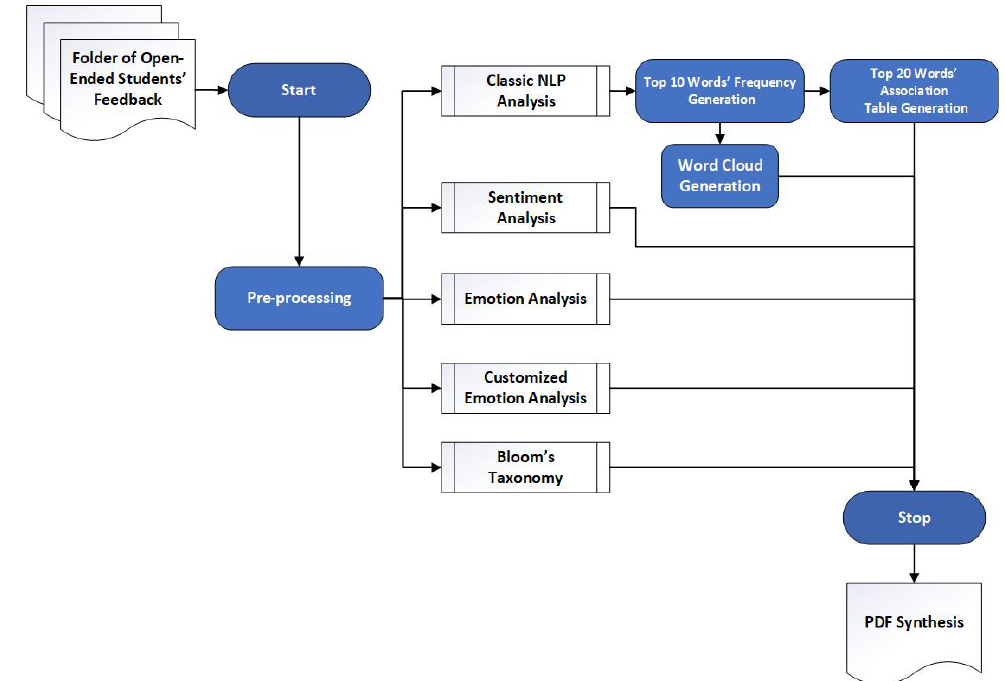
Figure 1. A block diagram illustrating the components of the proposed